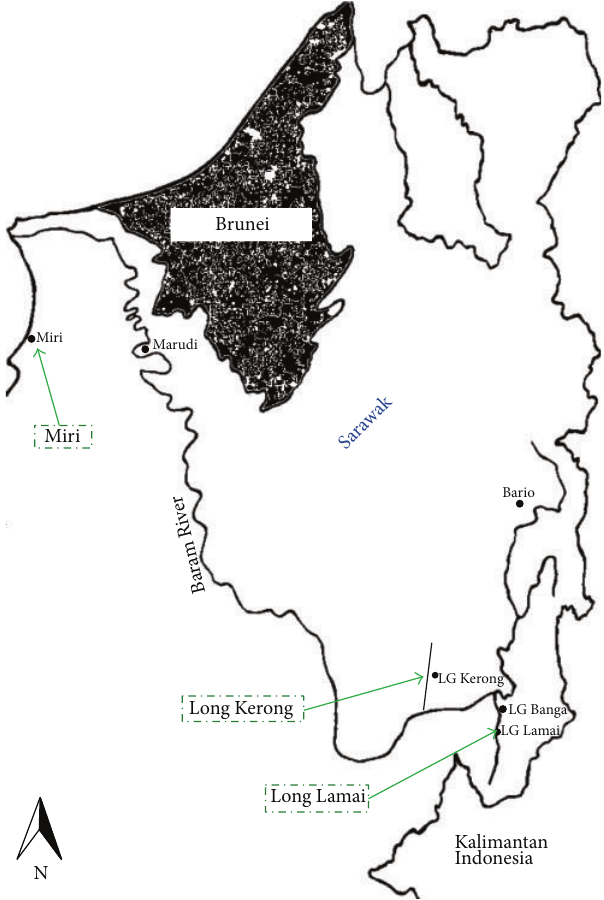
Figure 1: Location of Longa Lamai, Long Kerong, and Miri in the state of Sarawak,